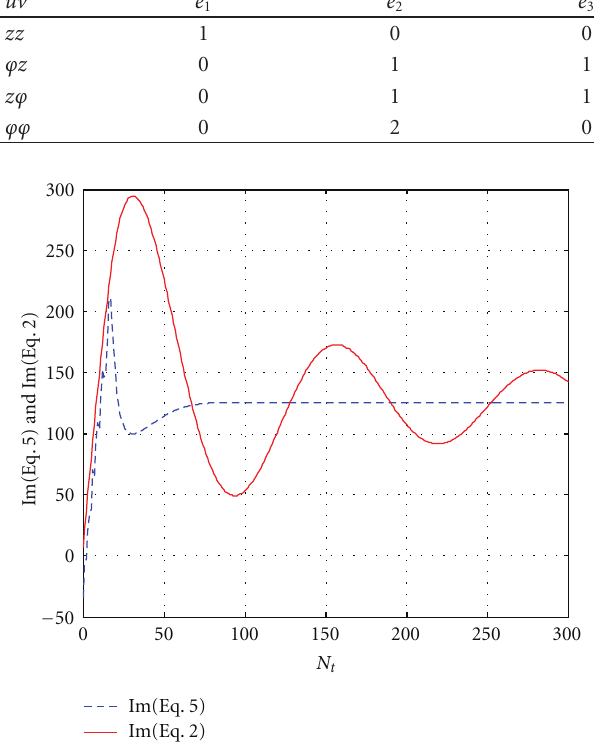
Figure 1: Comparison of (cid:2) G E and (5).